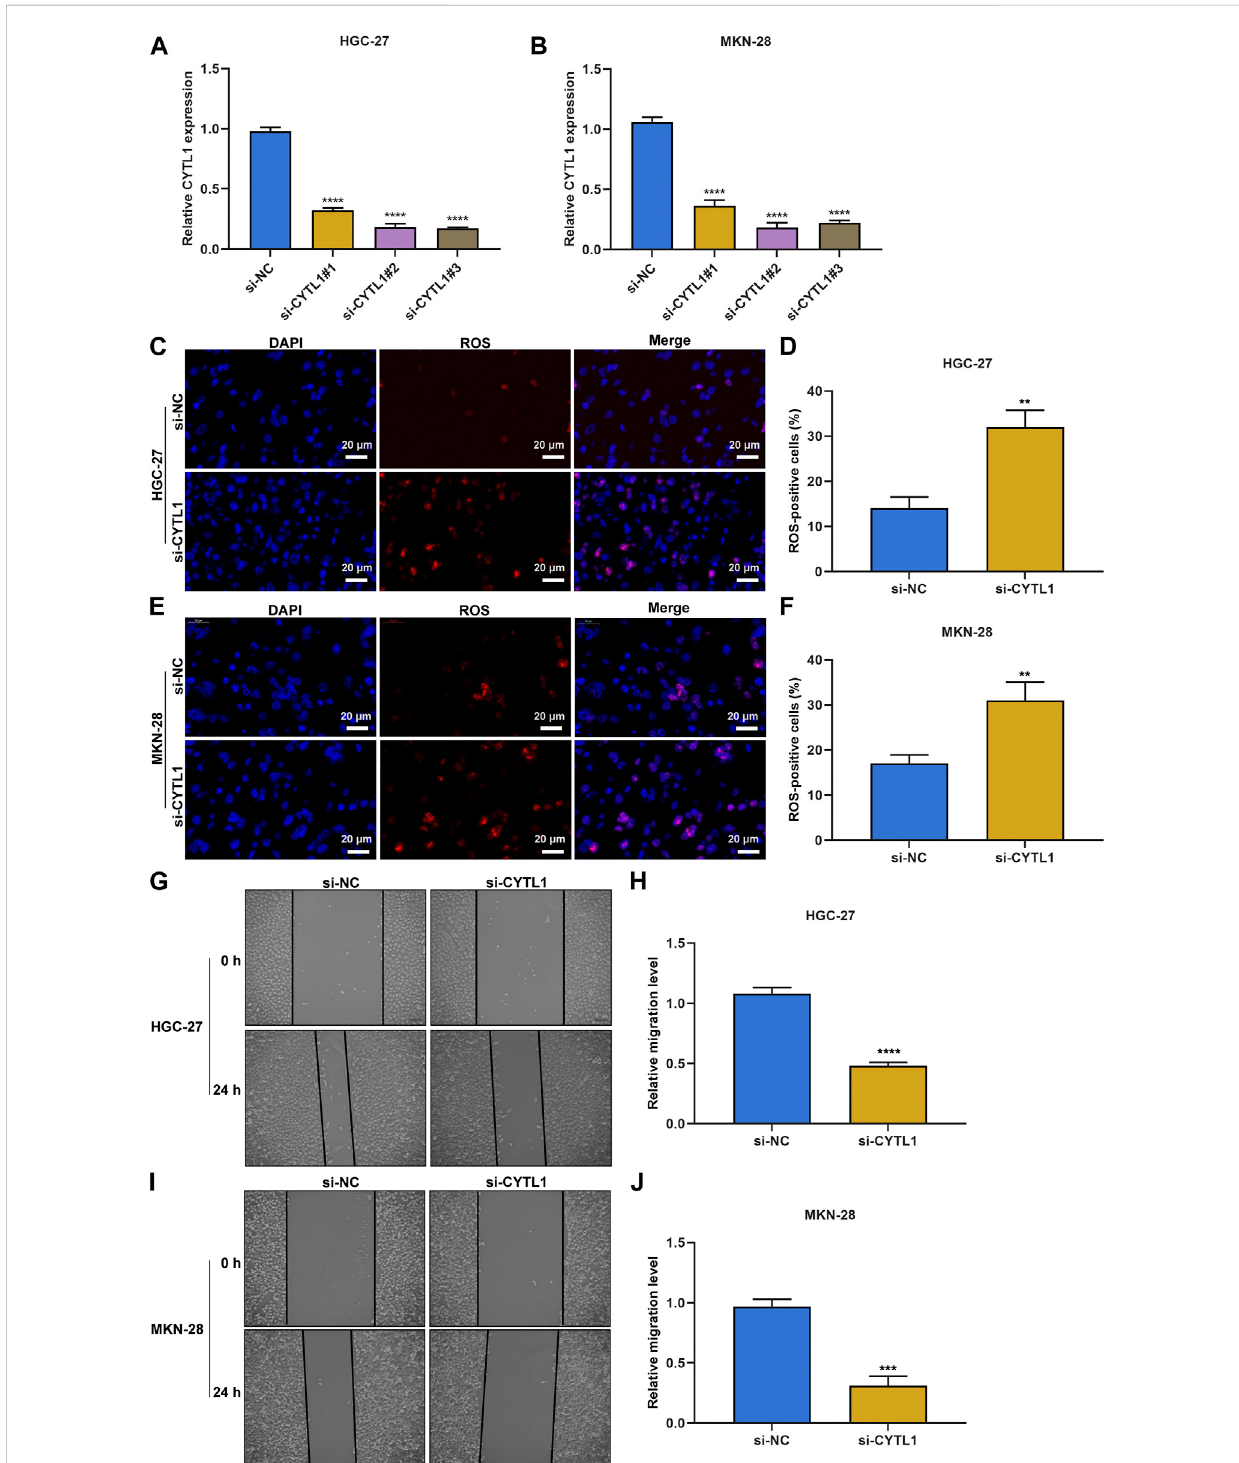
FIGURE 10 Silencing CYTL1 facilitates intracellular ROS accumulation and impairs migrative capacity of gastric cancer cells. (A,B) RT-qPCR of the expression of CYTL1 in HGC-27 and MKN-28 cells transfected with siRNAs targeting CYTL1. (C – F) ROS fl uorescence probe detecting intracellular ROS in transfected HGC-27 and MKN-28 cells. Bar, 20 μ m. (G – J) 0-h and 24-h photographs of wound healing experiment for transfected HGC-27 and MKN-28 cells. Bar, 50 μ